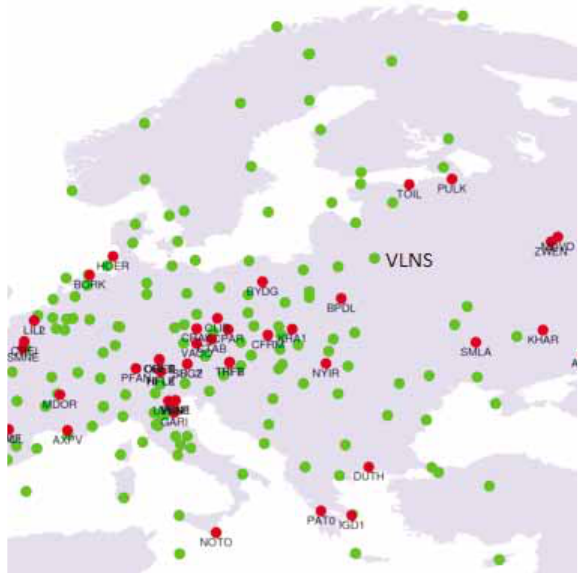
Fig. 2. A fragment of the map presenting station categories (green dots – class A, red dots – class B